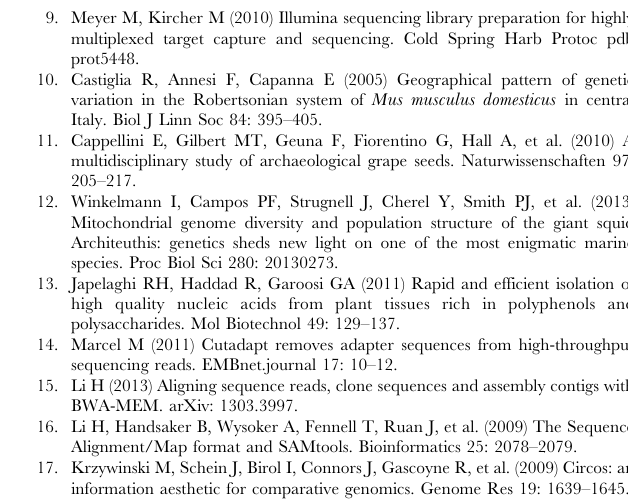
Figure S1 Amplicon with or without homologous M13 adaptor sequence strategy. Figure S2 CapFlank used to capture four novel full mitochondrial genomes from Southeast Asian mice.